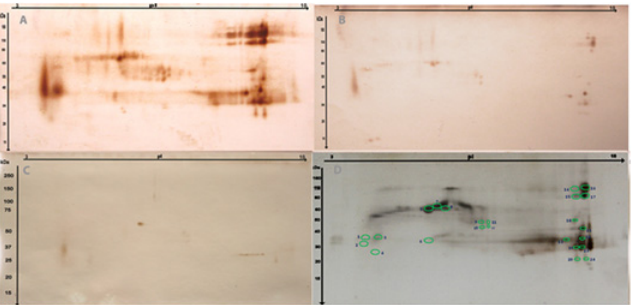
Fig 1. 2-D gel electrophoresis, silver staining and western blotting of Toxocara canis Excretory Secretory Antigens (TES-Ag). The TES-Ag sample was separated and analyzed using 2D gel electrophoresis and western blotting. Three of the 2DE gels were transferred to nitrocellulose membranes and probed with a strong EIA positive Toxocara human sera pool (A), a negative human serum sample (B), and Baylisascaris procyonis positive serum (C).A reference gel was stained using silver stain (D). The circled spots in D represent proteins that were excised and subjected to mass spectrometry analysis.